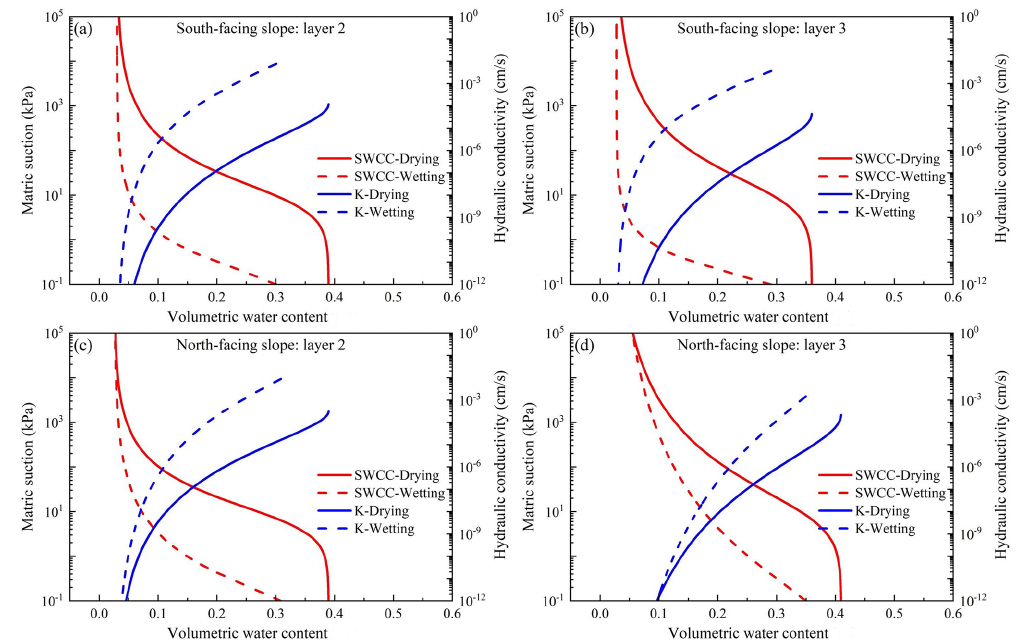
Figure 8. Soil water curve obtained using the TRIM test, where (a) layer no. 2 is on the south-facing slope, (b) layer no. 3 is on the south-facing slope, (c) layer no. 2 is on the north-facing slope, and (d) layer no. 3 is on the north-facing